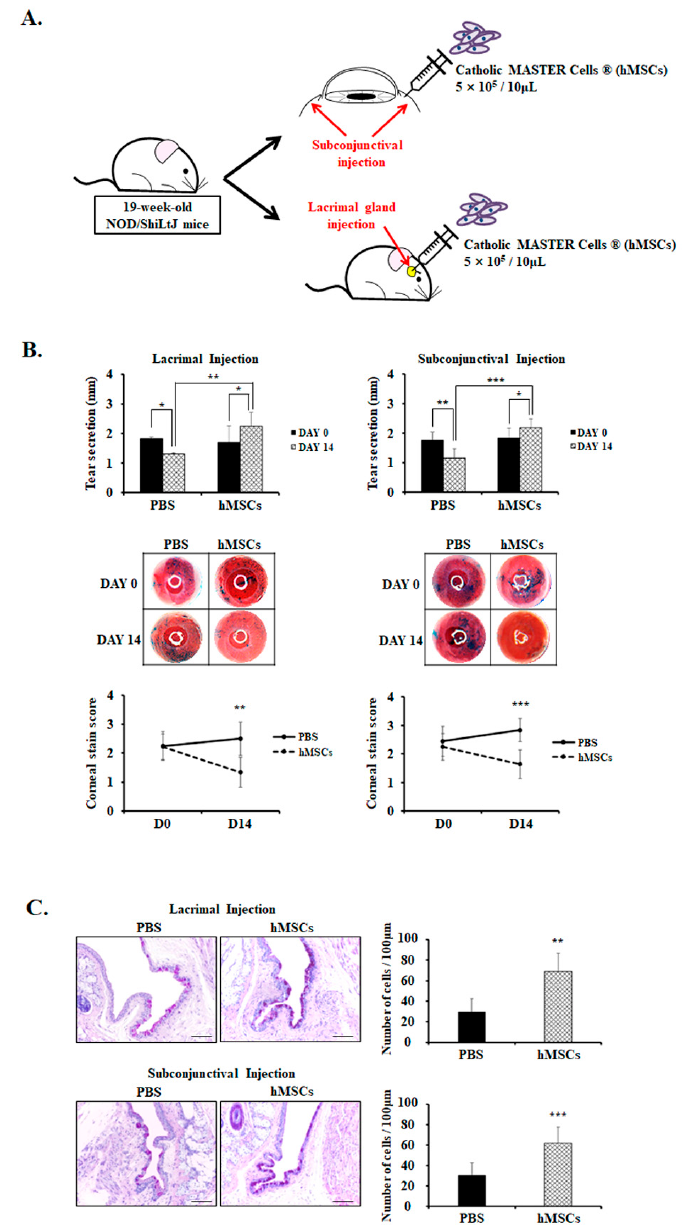
Figure 1. Analysis of clinical parameters and goblet cell count for PBS-treated or hMSCs-treated SS mouse model. ( A ) Schematic representation of the administration of the hMSCs through either the subconjunctival or lacrimal gland injection in 19-week-old NOD/ShiLtJ mice. ( B ) Tear secretion volume for mice treated with PBS or hMSCs by lacrimal gland or subconjunctival injection. Tear volume was assessed by the phenol red thread test on day 0 and day 14. The corneal stain scores were evaluated by lissamine green staining, as shown by representative photomicrographs. ( C ) Represen- tative PAS staining photographs of the conjunctiva signifying the goblet cell density and numbers. Scale bar: 50 µ m. Data are presented from six independent experiments ( n = 6). * p < 0.05, ** p < 0.01, *** p <